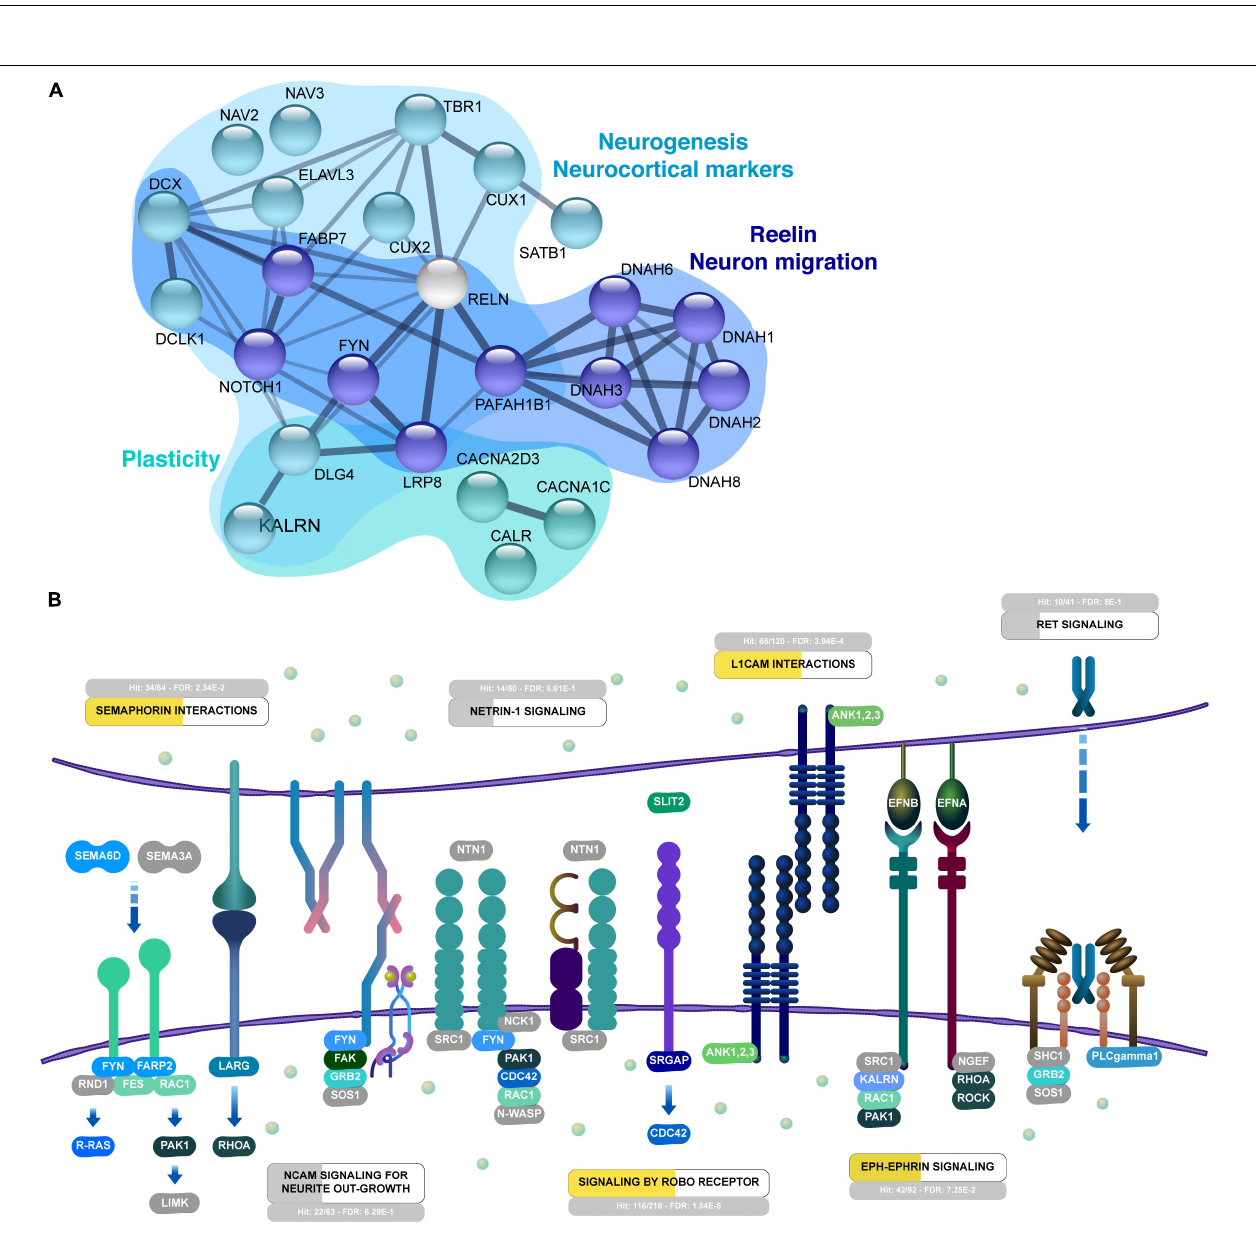
FIGURE 5 | Calcium response to ATP and KCl stimulation of cerebral organoids. PSC-derived cerebral organoids grown for (A–C) 30 or (G–I) 45 days had their cells dissociated and plated for 10 days on 15 mm coverslips. Cultured cells shown in (A,G) bright field and (B,H) under fluorescence. (C,I) Selected cells are shown in the same microscope field under fura-2 fluorescence in SCCI experiments. Typical responses are shown for cells when stimulated with (D) 100 µ M ATP or (E,J) 50 mM KCl. As shown in (C–E) , only one cell (#74) responded exclusively to ATP (yellow arrow), whereas several cells (# 3, 31, 82, 83, 84) responded to KCl (pink arrows), in 30-day cerebral organoids. As shown in (I,J) selected cells (# 21, 36, 38, 40, and 41) were only responsive to 50 mM KCl (pink arrows) in 45-day cerebral organoids. Post-stimulation, coverslips were fixed and cells labeled for (F) nestin, (K) TUJ1/tubulin β III (TUBB3), or MAP2 (L) scale bars 50 µ m. Areas under the